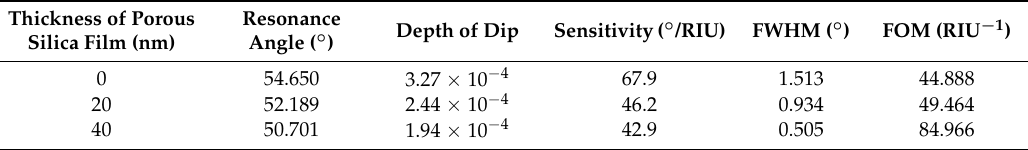
Table 4. The performance parameters of the SPR sensors with 0 (traditional SPR sensor), 20, and 40 nm thick 80% porosity porous silica film ( n ps = 1.086).